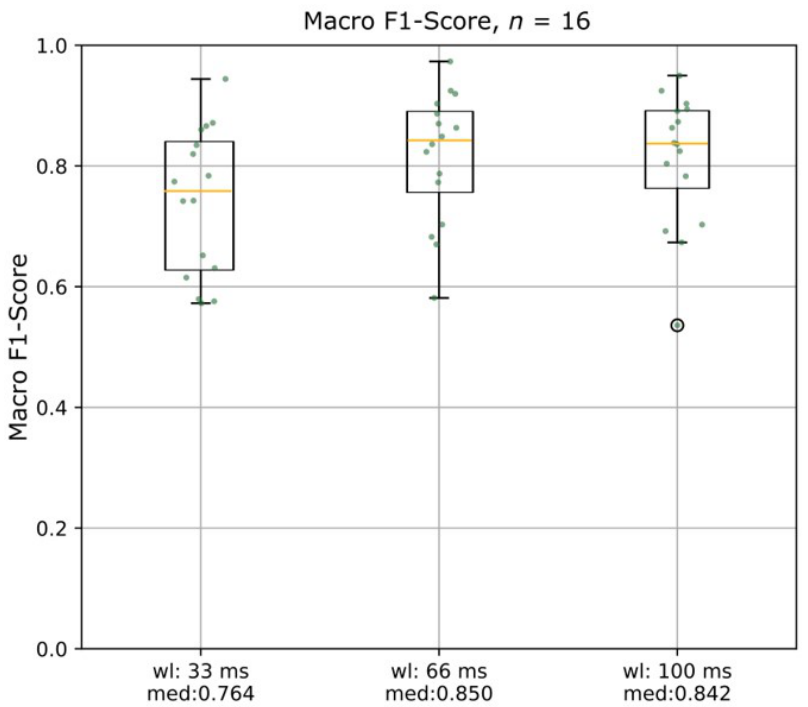
Figure 2. Boxplots of the comparison of the macro F1-scores of different window lengths (33 ms, 66 m, and 100 ms) using the two best-performing muscles in each patient. There was no signifi- cant difference between the three chosen window lengths. wl = window length; med = median macro F1-score.